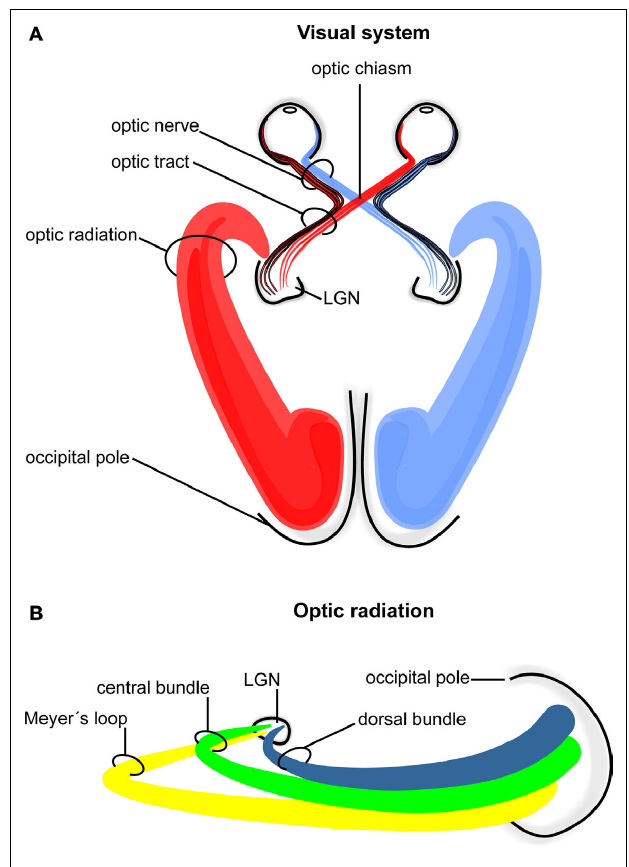
FIGURE 1 | Schematic drawing of the human visual system. (A) Right- and left-hemispheric fi ber pathways. (B) Left-hemispheric optic radiation comprising the anterior bundle termed Meyer’s loop (yellow), the central bundle (green), and the dorsal bundle (blue). LGN, lateral geniculate